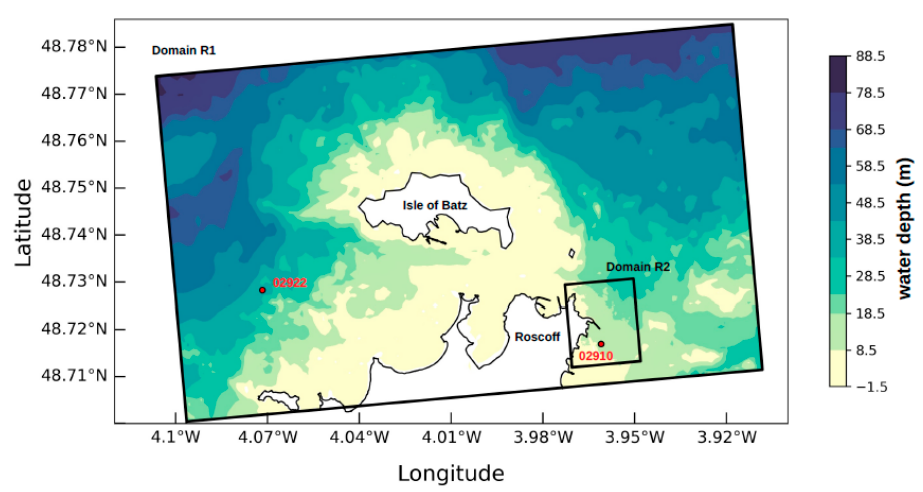
Figure 2. Spatial extent of the embedded computational domains R1 and R2 with locations of wave buoys 02922 and 02910 (CANDHIS database).